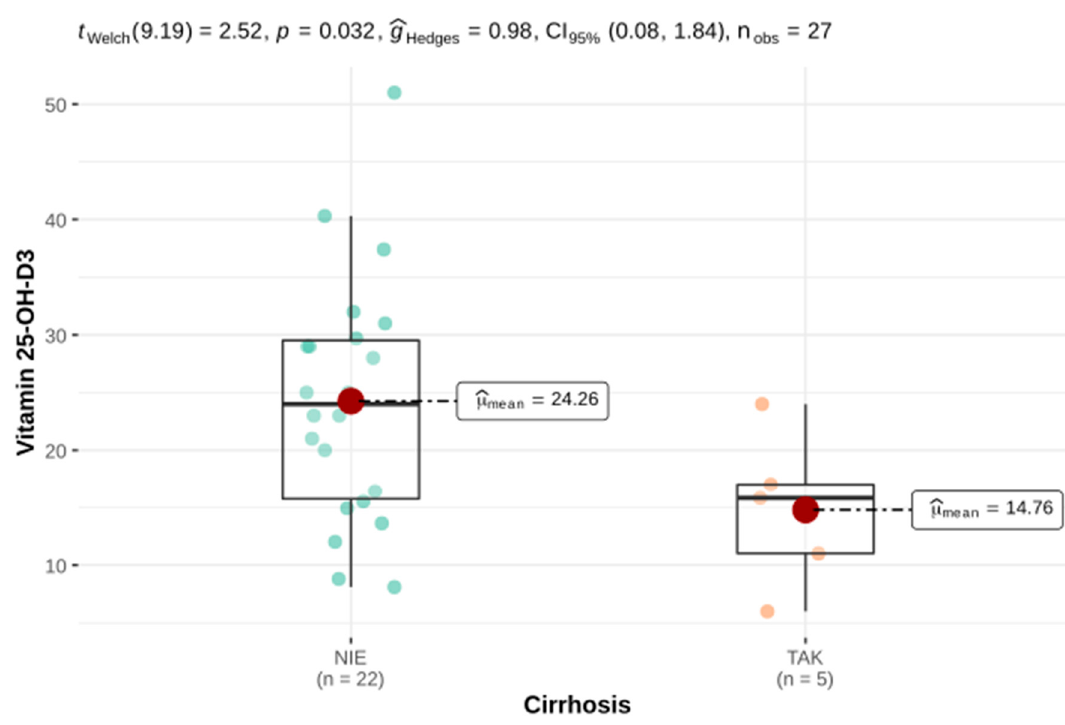
Figure 4. Serum 25-OH-D3 concentration in the group of patients with HH: on the left, patients without liver cirrhosis; on the right, with diagnosed cirrhosis.